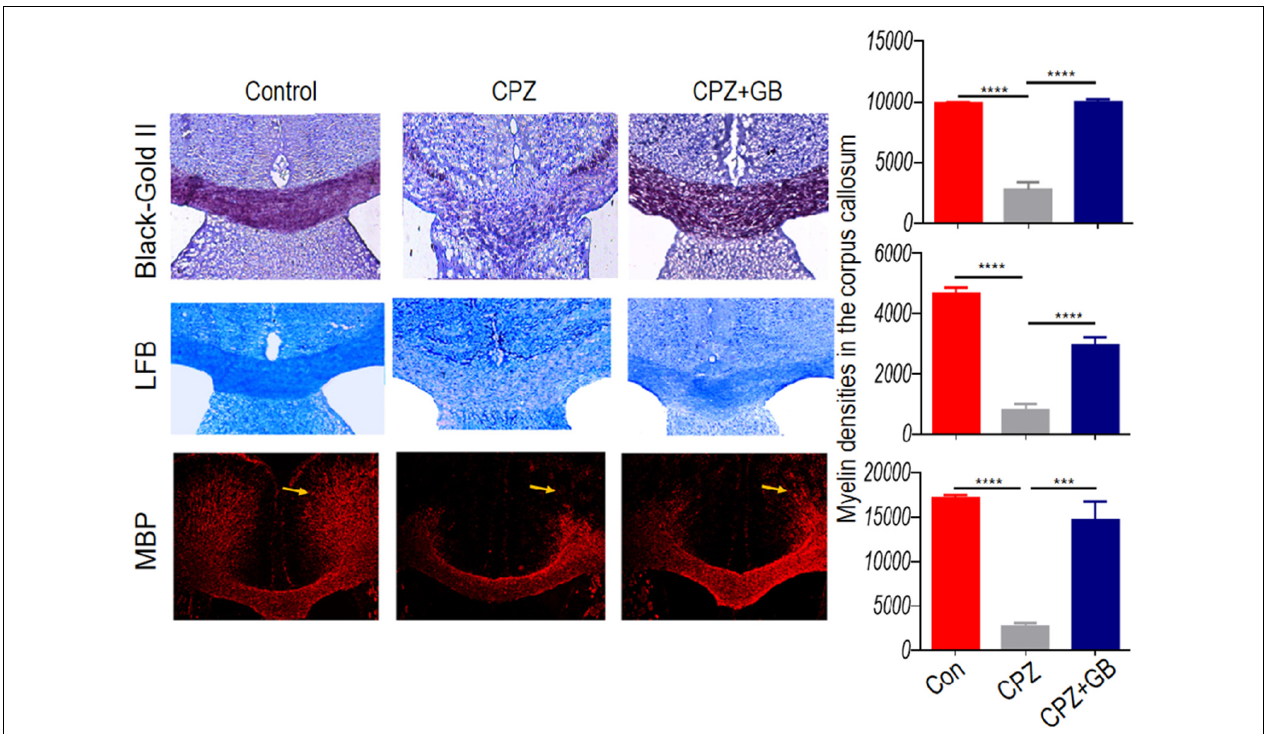
FIGURE 2 | GB promoted remyelination in CPZ-induced demyelination. Mice were fed with chow containing 0.2% CPZ for 6 weeks and were intraperitoneally injected with GB for 14 consecutive days from the 4th to 6th week of CPZ feeding. Histological evaluation of demyelination was carried out by Black Gold II, luxol fast blue (LFB) and myelin basic protein (MBP) staining ( n = 3–4/each group), and quantified by Image-Pro Plus 6.0 software. Representative images of Black Gold II, LFB and MBP staining are observed in the corpus callosum of the brain. The results represent the mean ± SEM. ∗∗∗ p < 0.001, ∗∗∗∗ p <